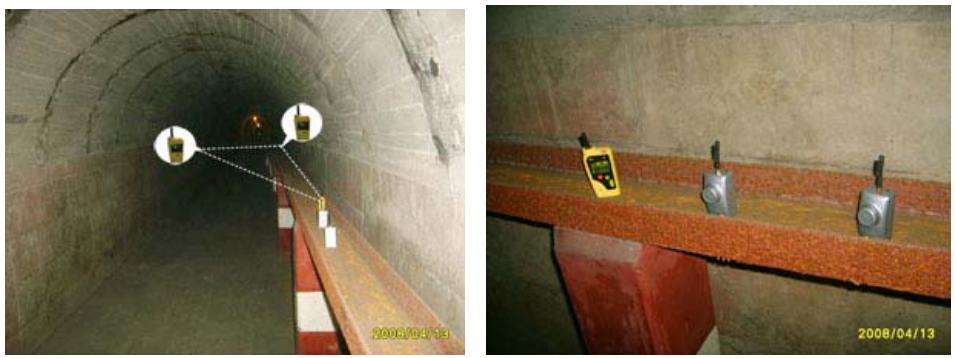
Figure 13. Experiments in the mine gas explosion laboratory.